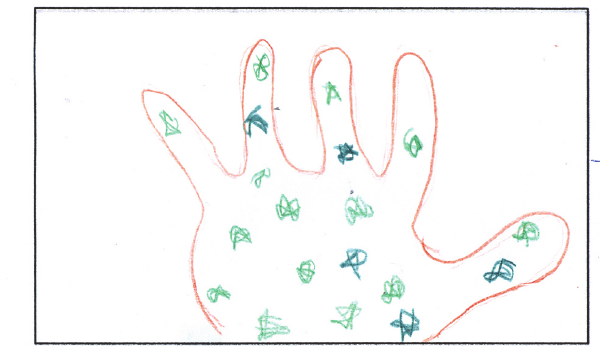
Figure 1. Childs drawing of a hand with germs on